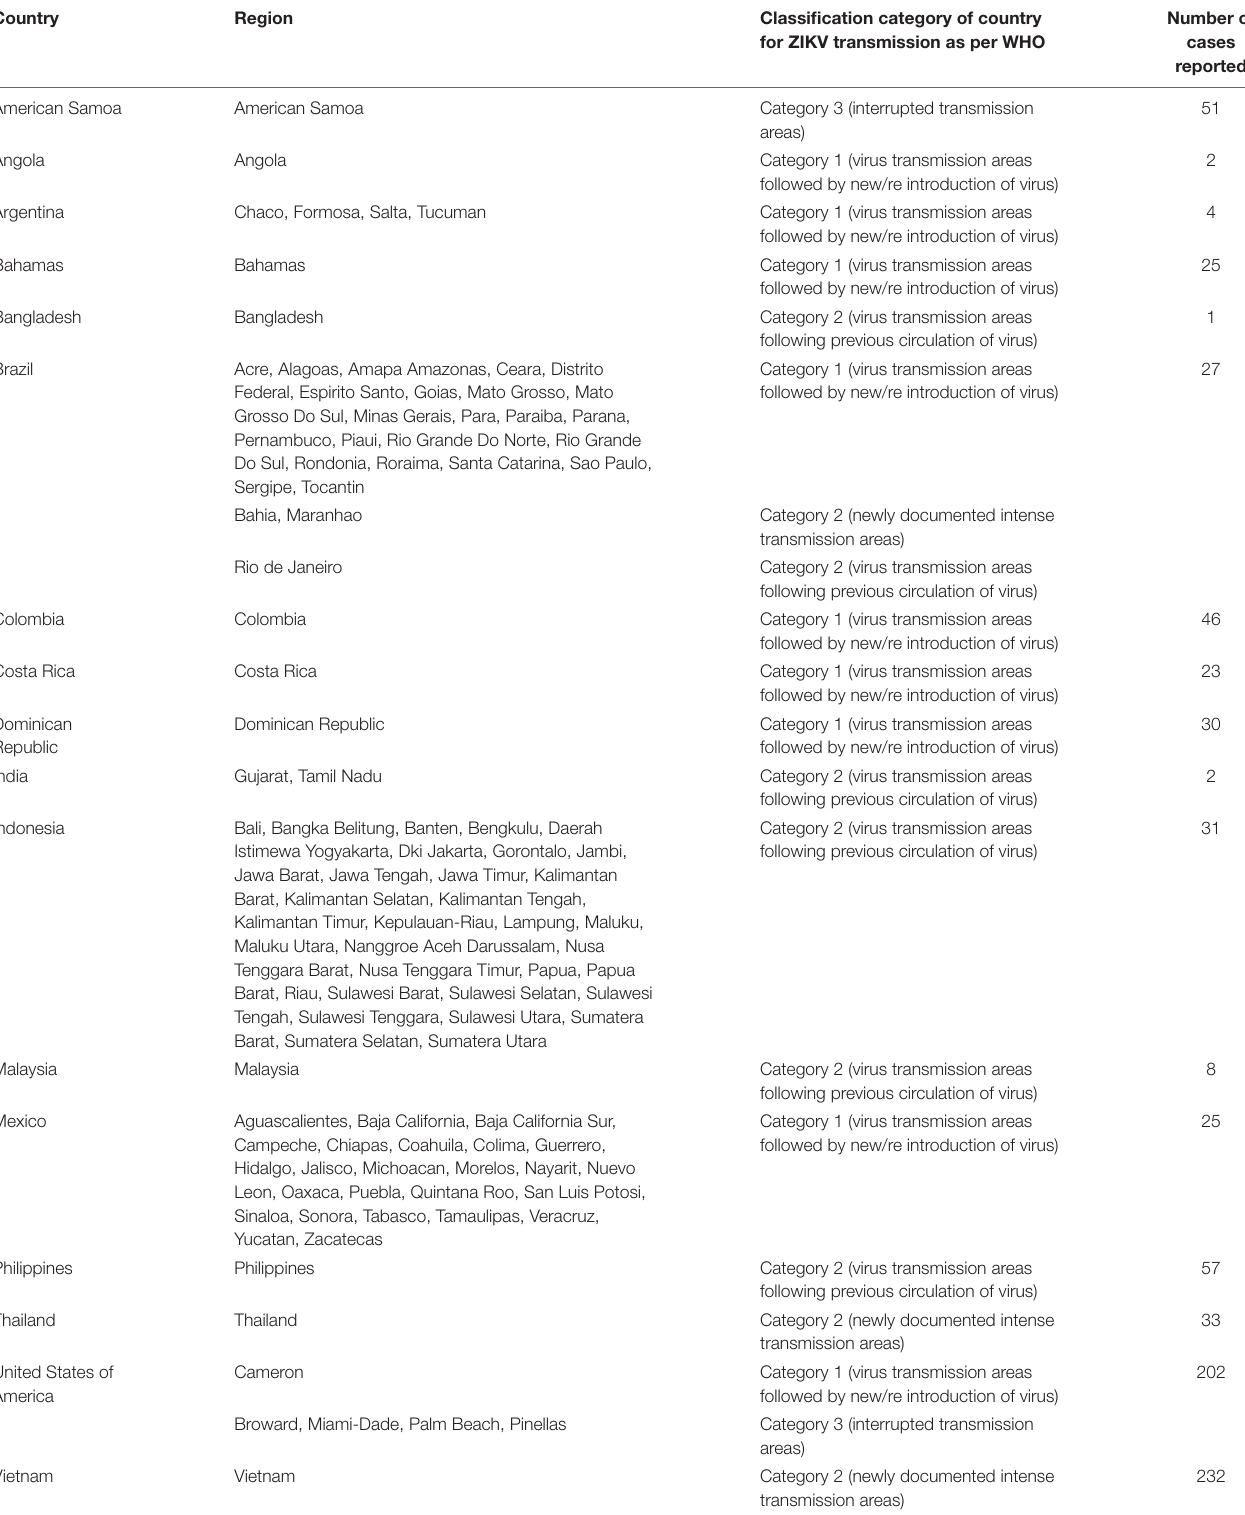
TABLE 1 | Table depicting ZIKV cases reported as of August 2017 and category classification by WHO (European Centre for Disease Prevention and Control [ECDC], 2017). Country Region Classification category of country